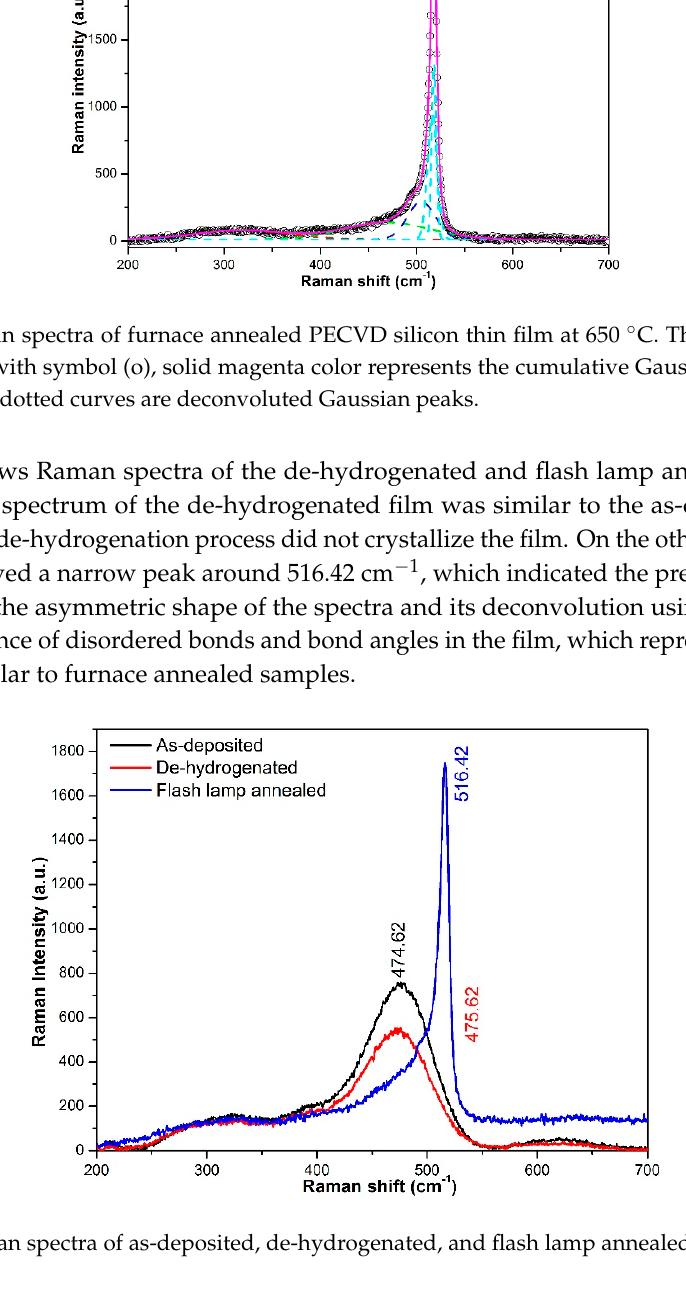
8 of 12 Figure 8. Raman spectra of furnace annealed PECVD silicon thin films at different temperatures. The Raman spectrum of the sample annealed at 650 °C was de-convoluted into four Gaussians curves shown by dotted lines in Figure 9. The fitting was performed by Origin software. The LO-TO (definition) phonon peaks centered at 505.30 cm − 1 and 518.31 cm − 1 were attributed to nanocrystalline silicon and crystalline silicon phases, respectively, whereas, the peaks at 317.61 cm − 1 and 469.76 cm − 1 were attributed to amorphous silicon phases [26,27]. The percentage crystallinity of the films was